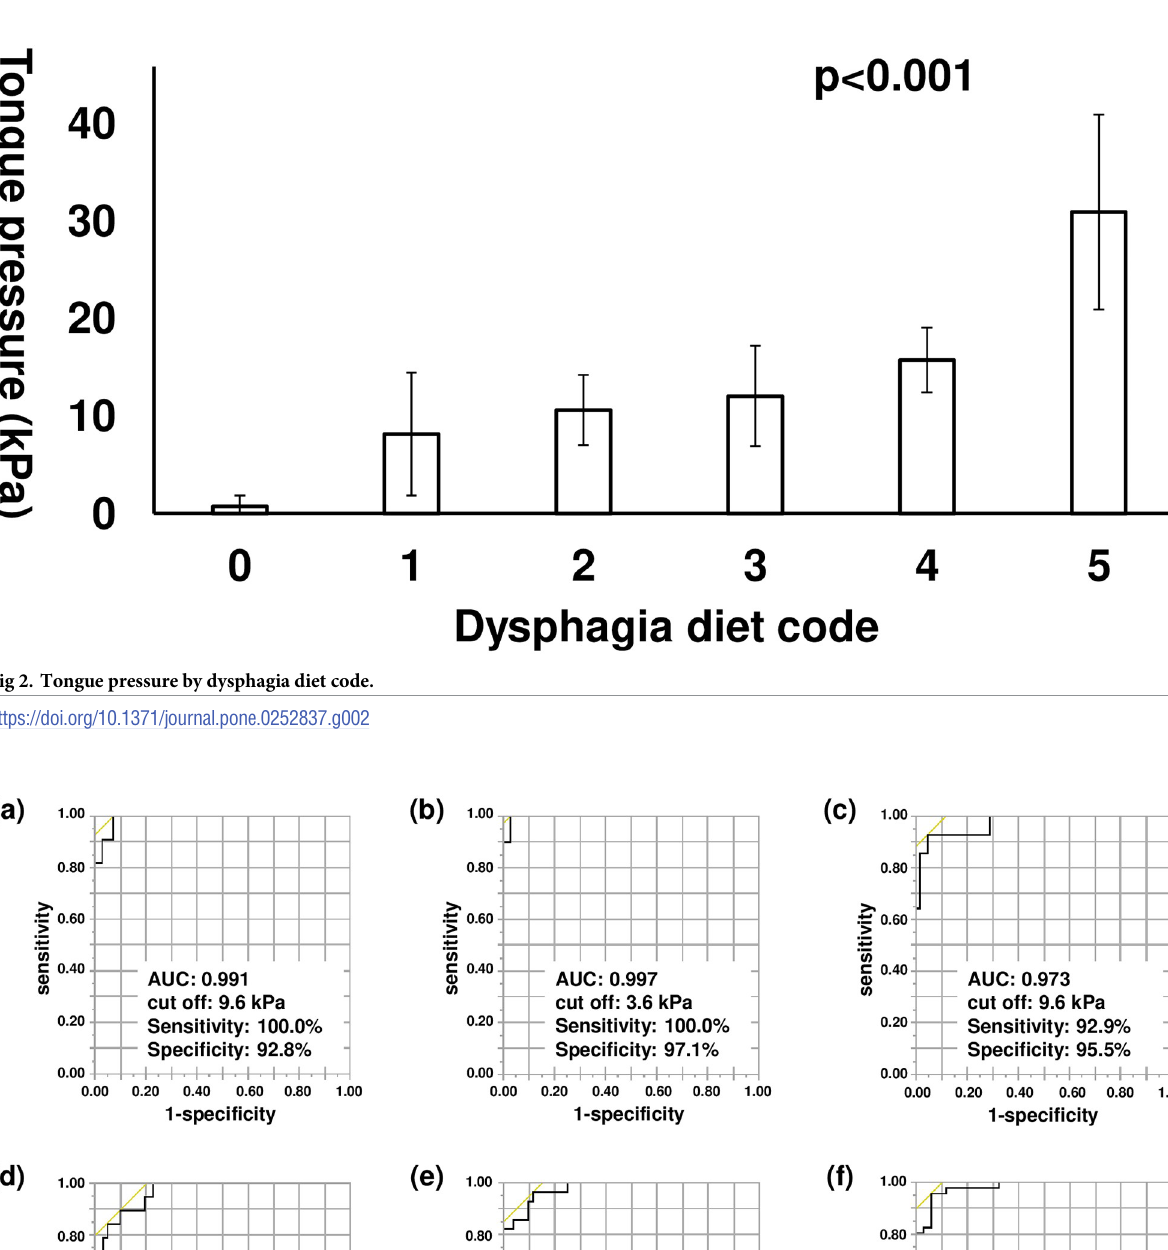
PLOS ONE | https://doi.org/10.1371/journal.pone.0252837 June 4,